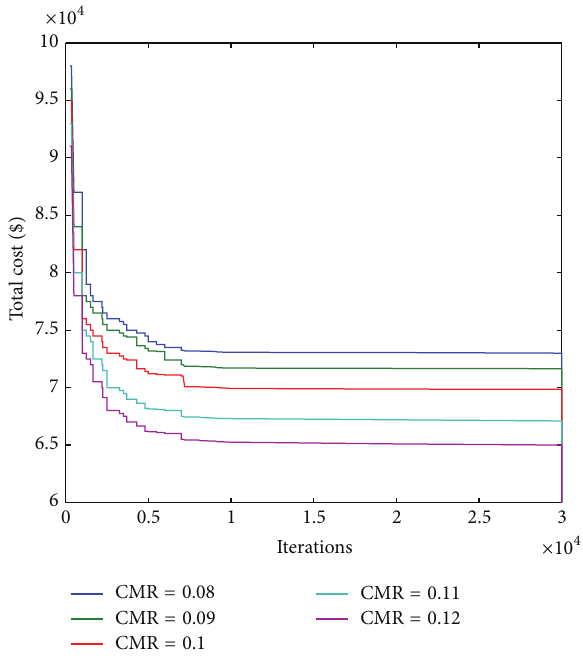
Figure 7: Variation of the optimum total cost using various techniques.